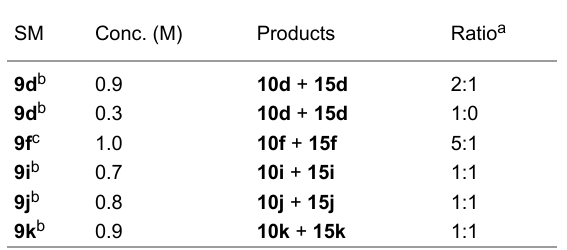
Table 3: Ratio between the formation of 10d , f , i , j , k and 15d , f , i , j , k at different reaction concentrations.